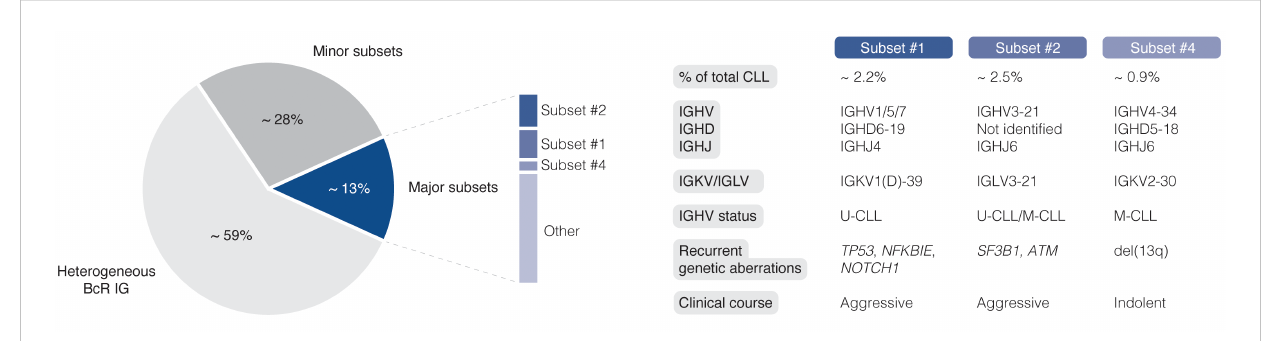
FIGURE 1 Clinicobiological pro fi les of major CLL subsets #1, #2, and #4. BcR IG, B cell receptor immunoglobulin; U-CLL, CLL with unmutated IGHV genes; M-CLL, CLL with mutated IGHV